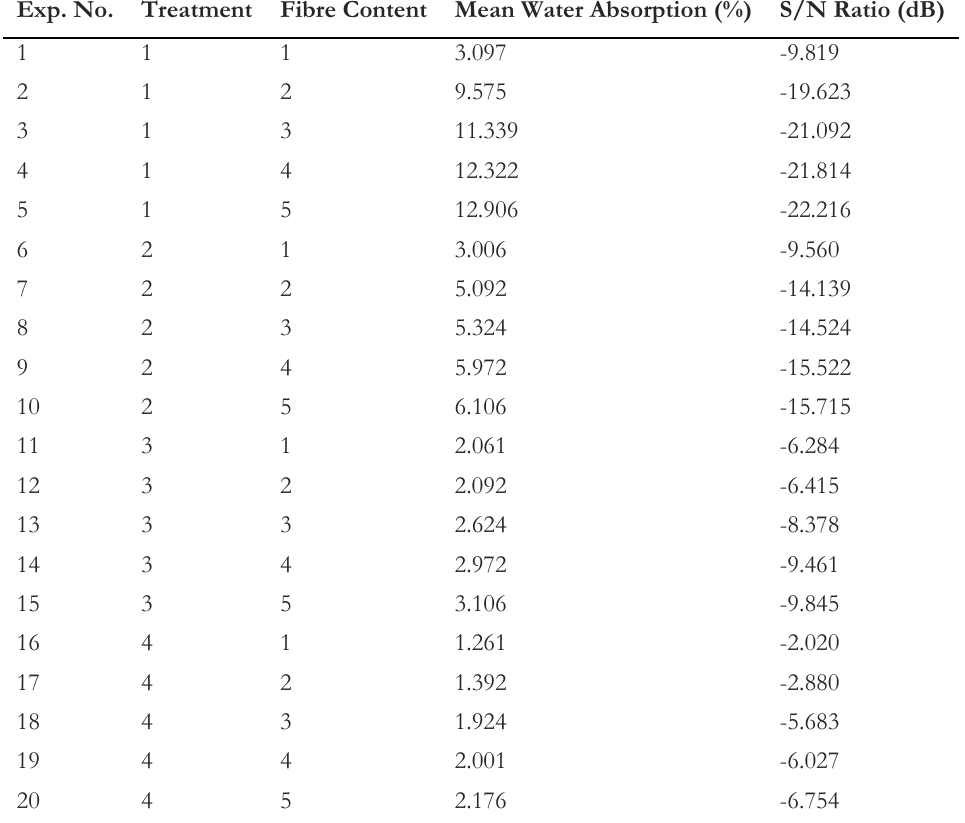
Table 5. Factor level, mean percentage of water absorption and their corresponding signal-to-noise level of bamboo fibre polyester composites.